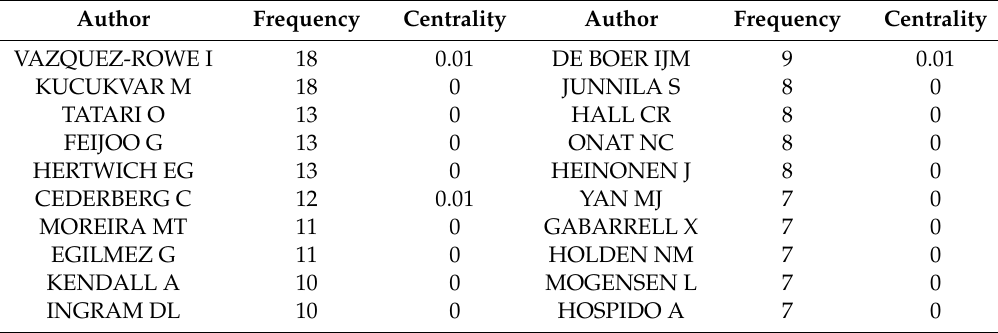
Table 9. Top 20 authors based on occurred